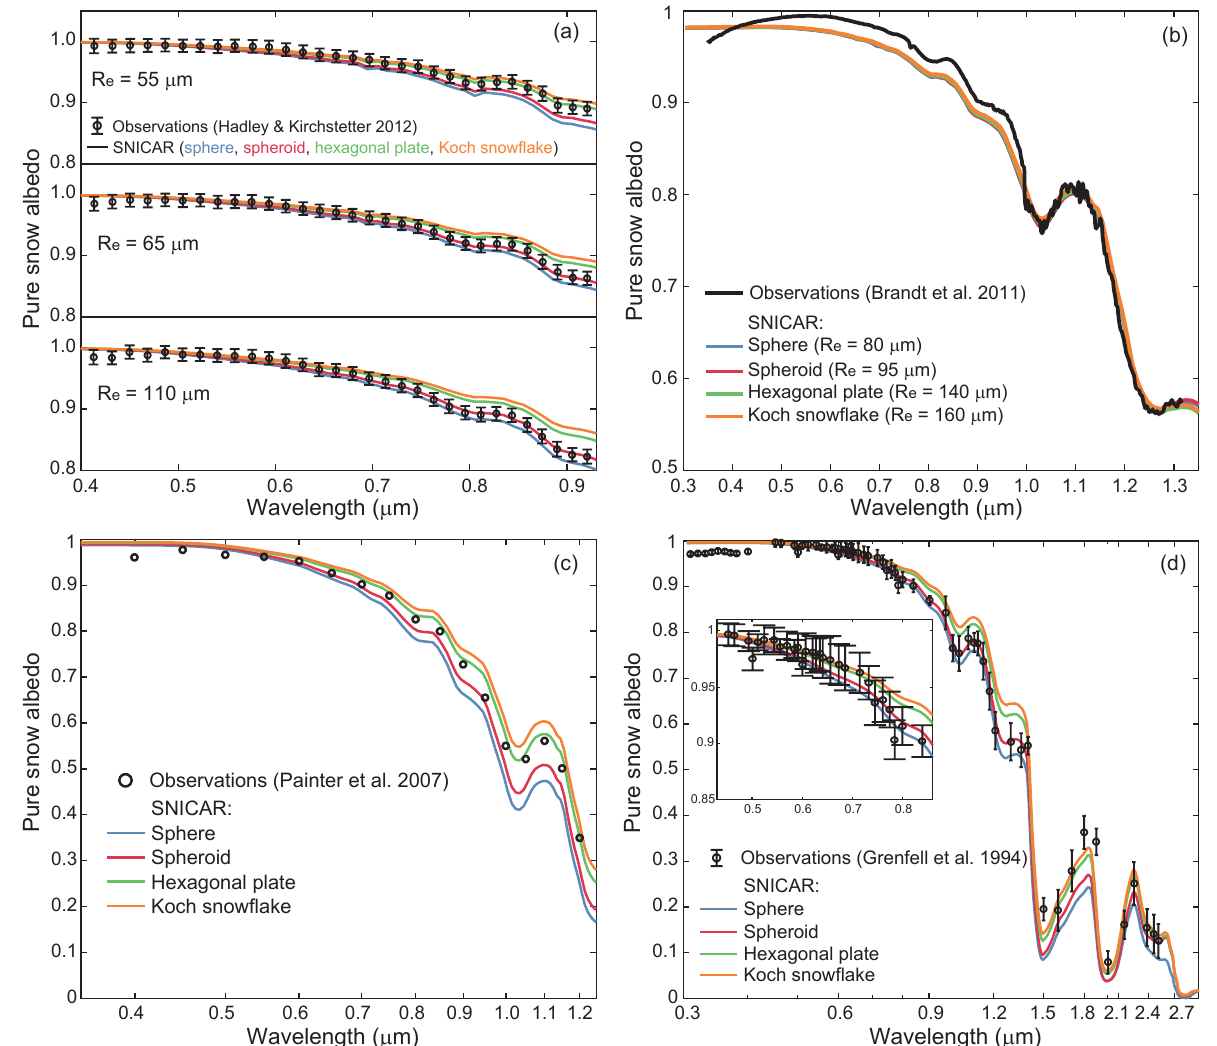
Figure 6. Comparisons of spectral pure snow albedo from observations (black) and SNICAR simulations using observed snowpack prop- erties (see Table 1 and text for details) and assuming sphere (blue), spheroid (red), hexagonal plate (green), and Koch snowflake (orange). (a) Observations are obtained from laboratory measurements (Hadley and Kirchstetter, 2012). (b) Observations are obtained from open-field experiments in New York (Brandt et al., 2011). The effective radii ( R e ) for each snow shape are obtained to best match observations at wave- lengths of 1–1.3µm. (c) Observations are obtained from field measurements over Rocky Mountains (Painter et al., 2007). (d) Observations are obtained from field measurements at the South Pole (Grenfell et al.,